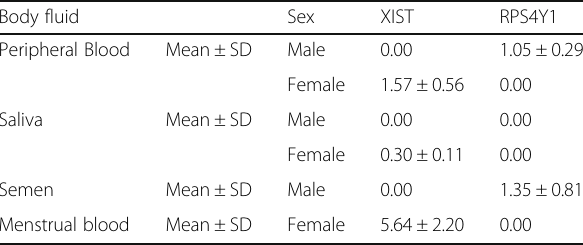
Table 3 Relative expression (RQ) values of XIST and RPS4Y1 in the studied male and female body fluids